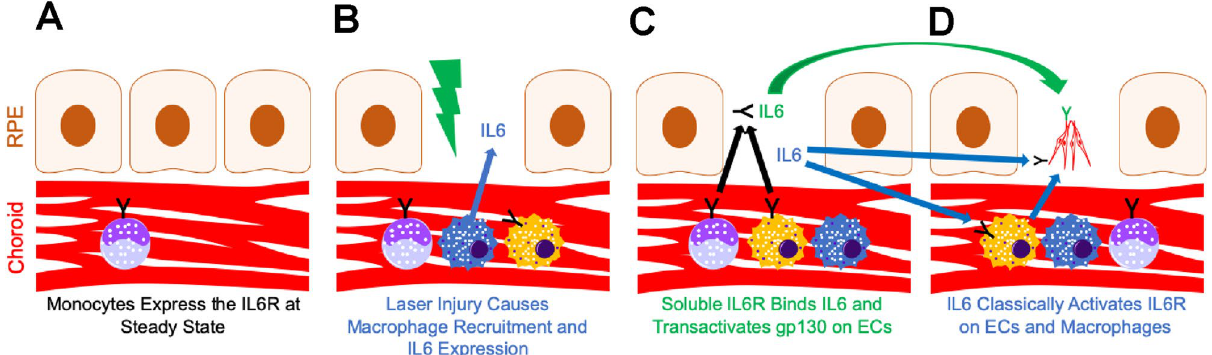
Figure 8. Model of IL6 signaling during CNV. ( A ) At steady state, IL6 is not expressed and the IL6R (Black Y) is expressed by monocytes (purple). ( B ) Laser injury (lightning bolt) causes macrophage influx into the choroid including IL6-expressing macrophages (blue) and IL6R + macrophages (yellow with black Y). ( C , D ) Soluble IL6R derived from monocytes and macrophages binds macrophage-derived IL6 and trans-activates (green arrow) gp130 (Green Y) on CNV endothelial cells. Macrophage-derived IL6 classically activates (blue arrow) the IL6R (Black Y) on endothelial cells and macrophages. D: IL6R + macrophages stimulate angiogenesis (blue